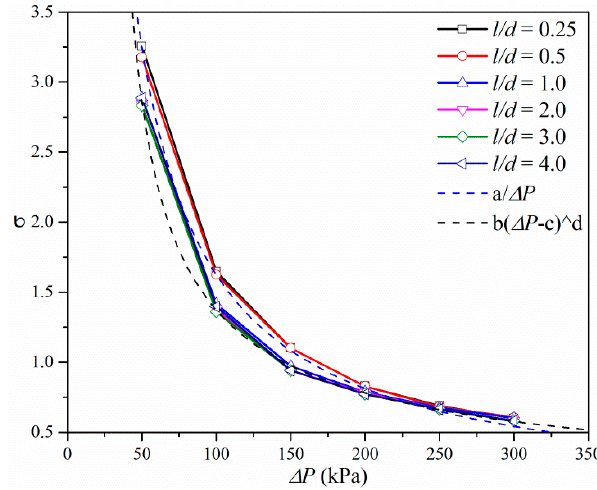
Figure 14. Cavitation number vs. pressure ratio and l/d .